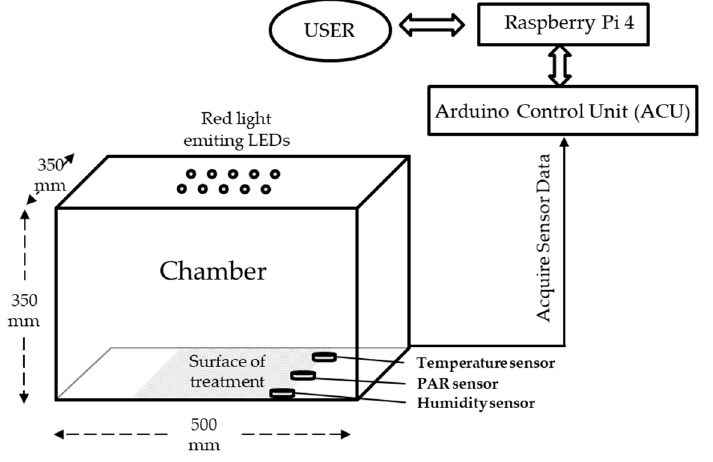
Figure 1. Dimensions, main components and operation workflow of the modulable spectrum plant experimental chamber.